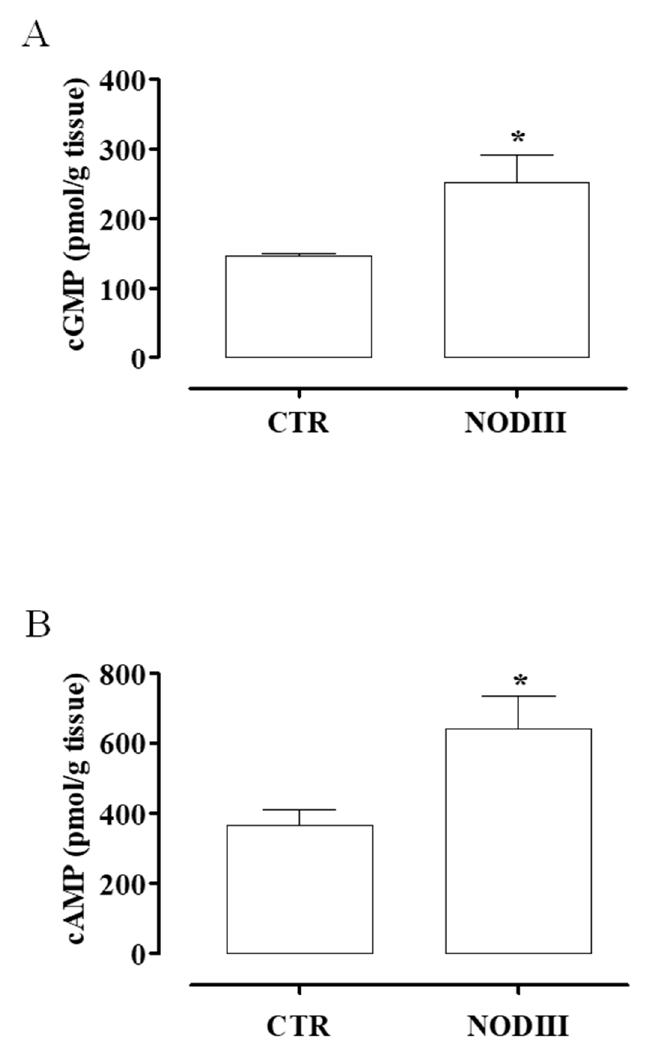
Figure 4. Changes in cAMP and cGMP content in uteri of CTR and NODIII mice. The uterus content of cGMP ( A ) or cAMP ( B ) is significantly increased in uteri harvested from NODIII mice vs. CTR mice (* p < 0.05). Results are expressed as pmol / g tissue and calculated as mean ± SEM ( n = 6 mice). Results are analyzed by unpaired Student’s t-test.